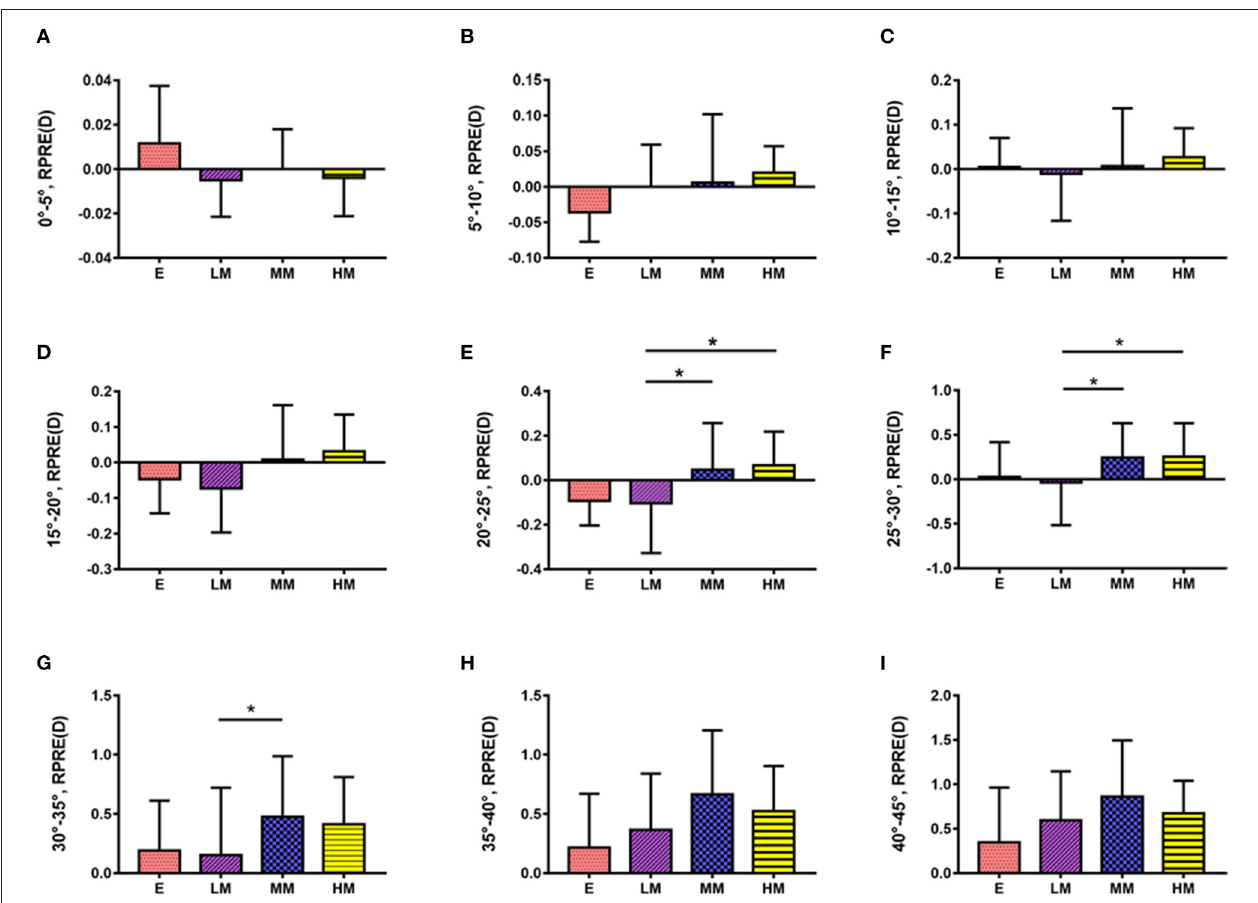
FIGURE 4 | Comparison of RPRE among four refractive groups in eccentricities between 0 and 5 ◦ , 5 and 10 ◦ , 10 and 15 ◦ , 15 and 20 ◦ , 20 and 25 ◦ , 25 and 30 ◦ , 30 and 35 ◦ , 35 and 40 ◦ , and 40 and 45 ◦ . * p < 0.05.